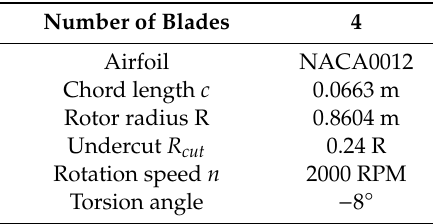
Table 3. Detailed parameters of the blades in the Robin fuselage / rotor interference flow field.